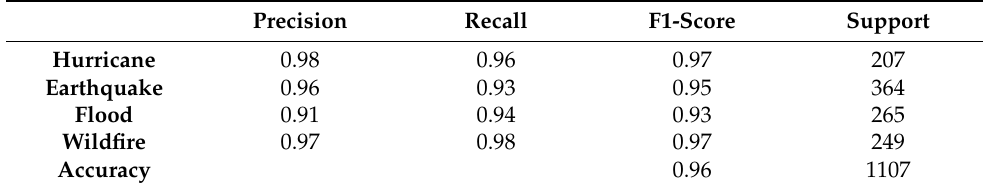
Table 11. Performance evaluation for the classification of severe weather events using VGG 19.